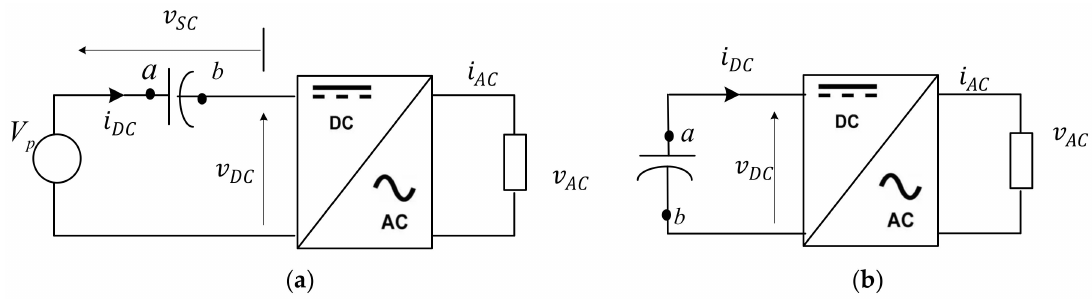
Figure 5. The basic circuit diagram of the SCAWI-PV inverter: ( a ) SC charging phase; ( b ) SC discharging